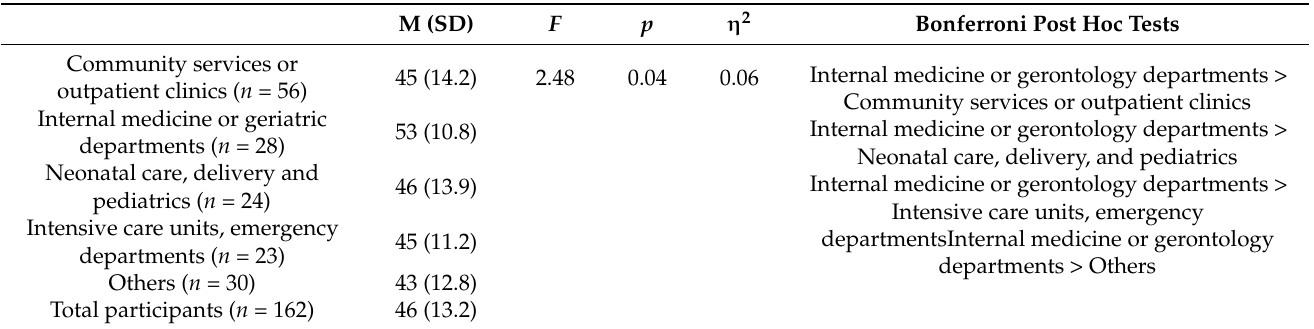
Table 3. Analysis of variance (ANOVA) of anxiety levels according to the nurses’ department or clinic of work ( n = 162).